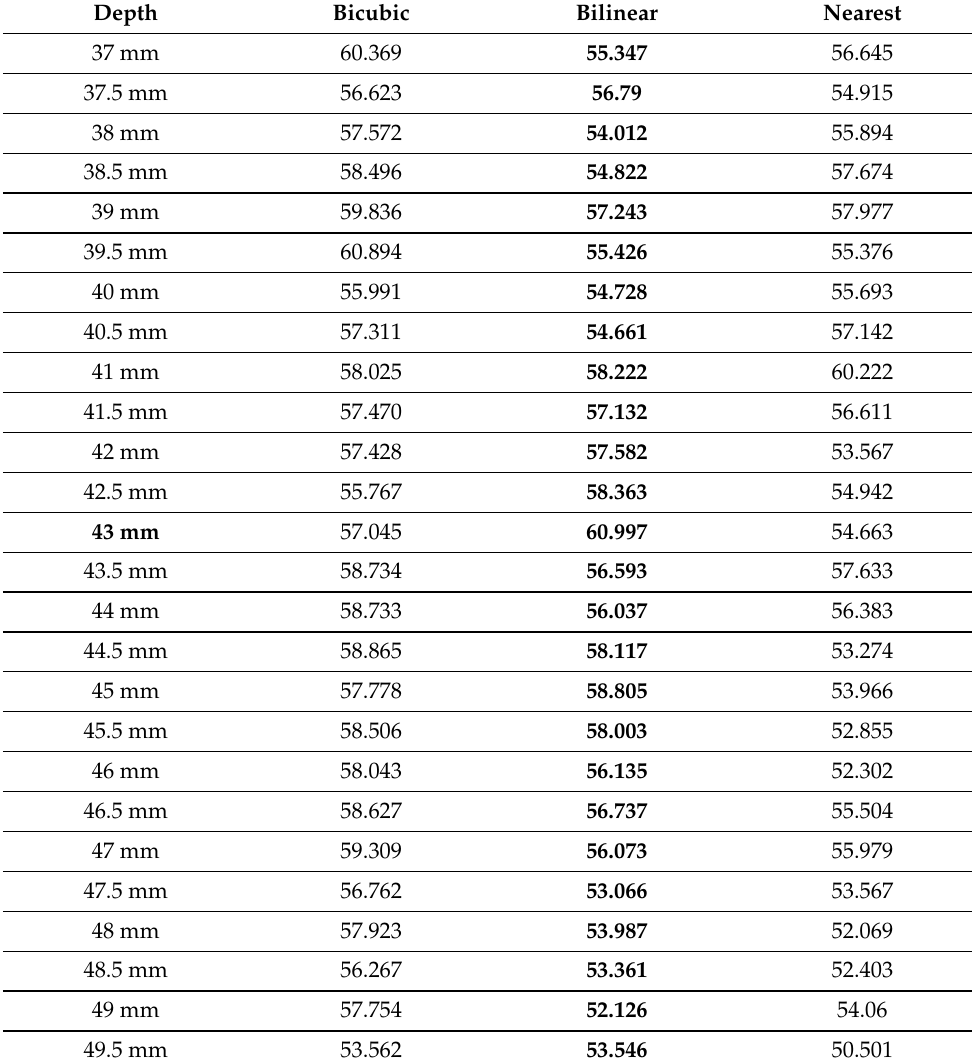
Table 3. Comparison of PSR values for interpolation methods, such as nearest, bilinear, and bicubic via reconstruction depths under photon-starved